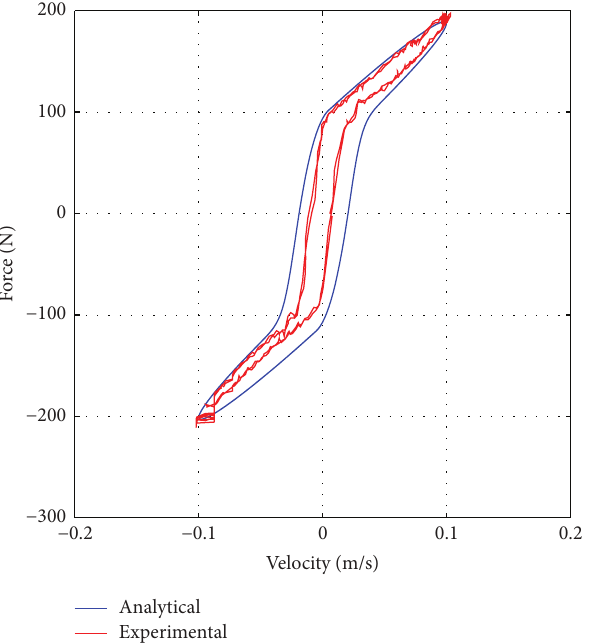
Figure 5: Force-velocity hysteresis in 2.5 Hz and zero current. Figure 6: Experimental and mathematical MR damper force in 2.5 Hz and zero current.